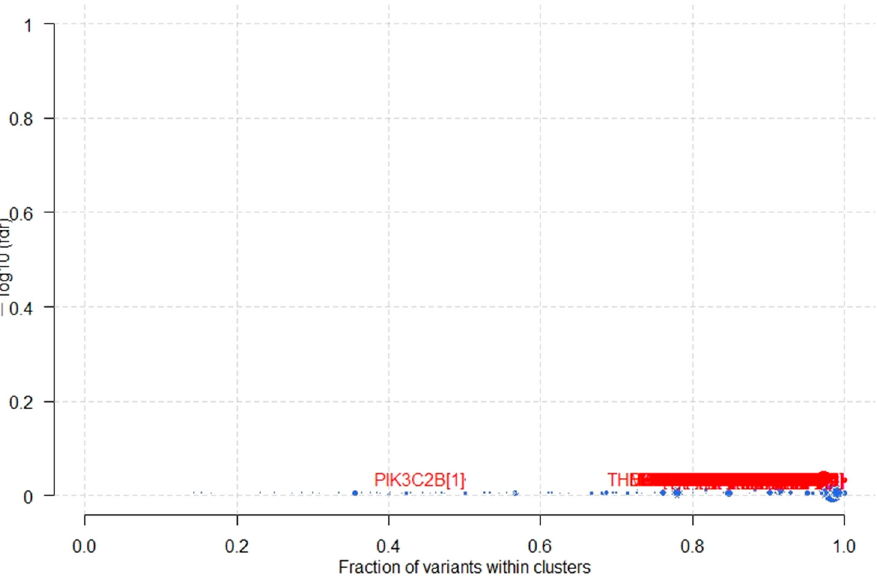
Figure 6. B-ALL associated potential driver genes identified by oncodrive in 12 B-ALL patients. The results are not statistically significant probably due to a smaller number of samples in the B-ALL cohort.